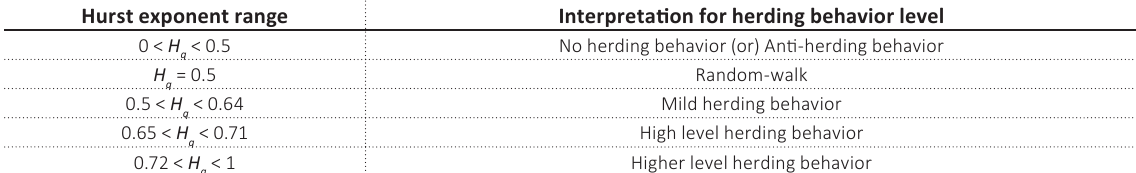
Table 4. Hurst exponent value range